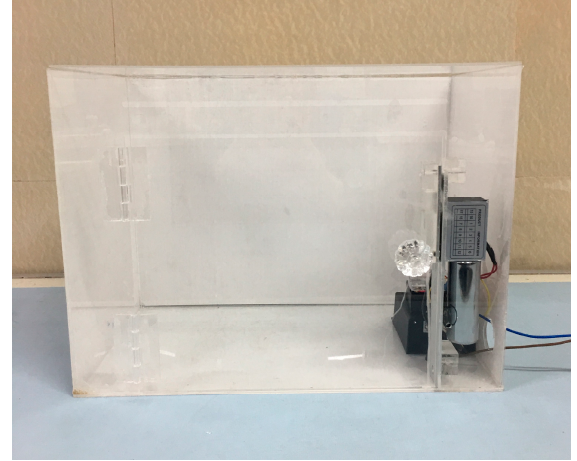
Figure 17. The intelligent mailbox based on voiceprint identification.